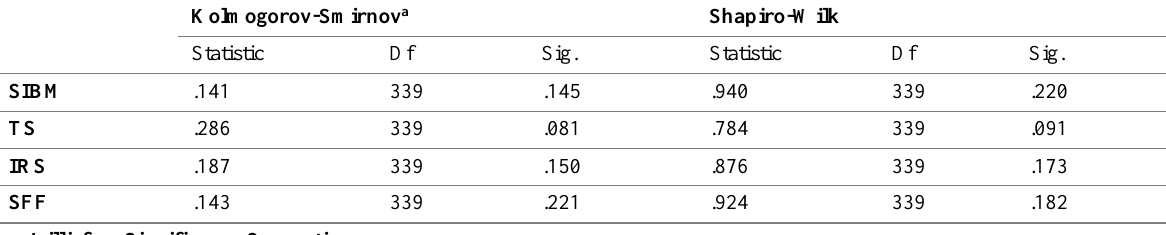
Table 2: Tests of normality